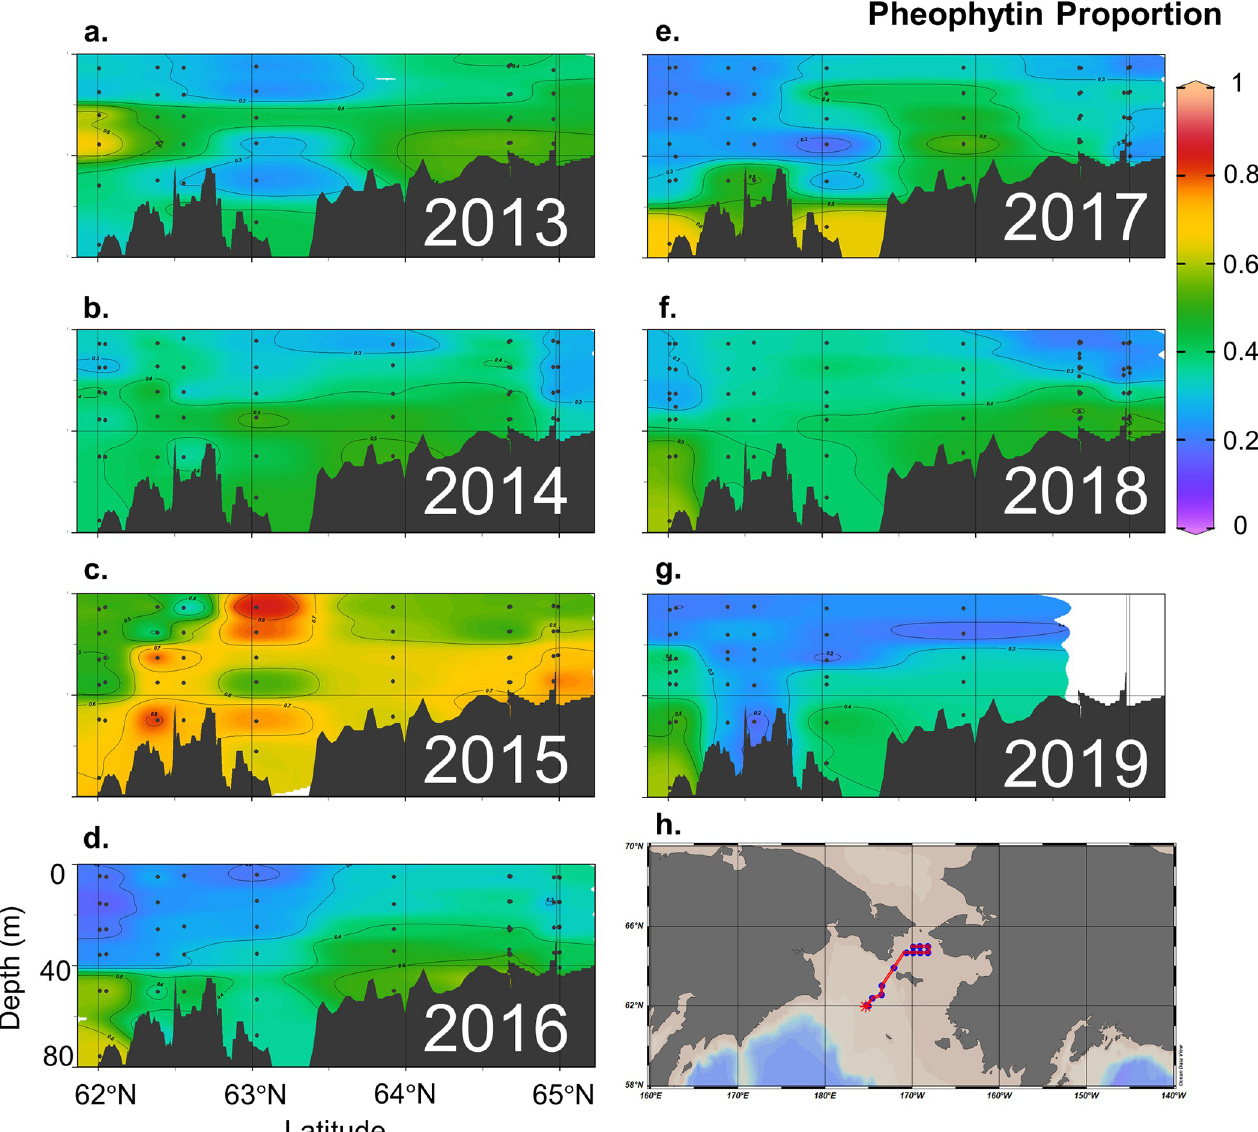
Fig 7. Transect views of pheophytin proportion based on combined chlorophyll a and pheophytin concentrations measured in units μ g/L at each collected depth. The annual latitudinal transects show DBO1 stations on the left and DBO2 stations to the right. Note: cruise samples for most DBO2 stations were missing in 2019. Figure constructed using Ocean Data View (version 5.3;